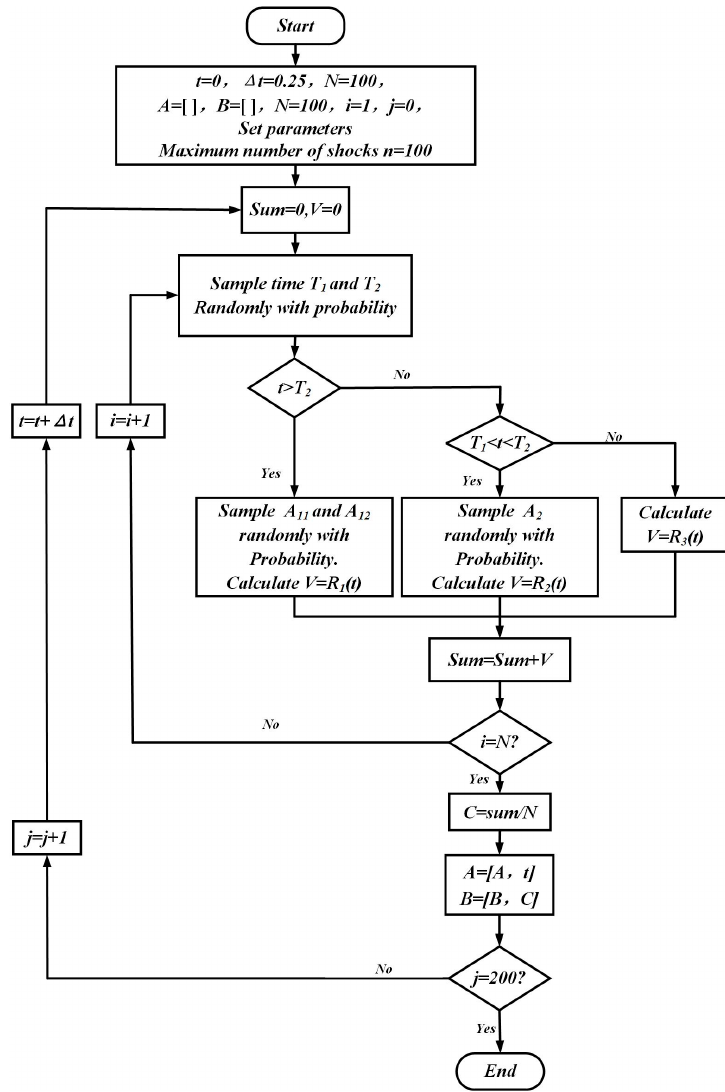
Figure 2. Flowchart of the reliability solving method.